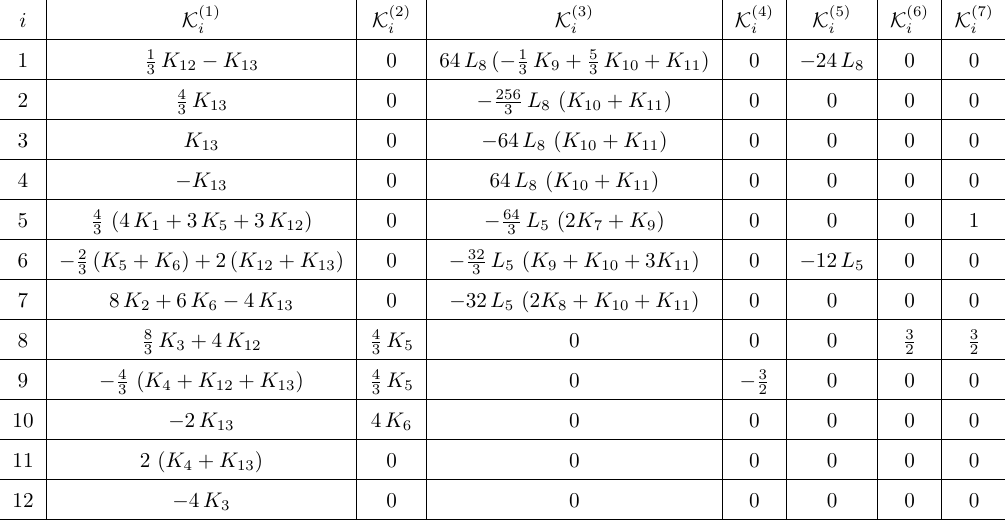
Table 11 . Large- N C parameters K ( k )